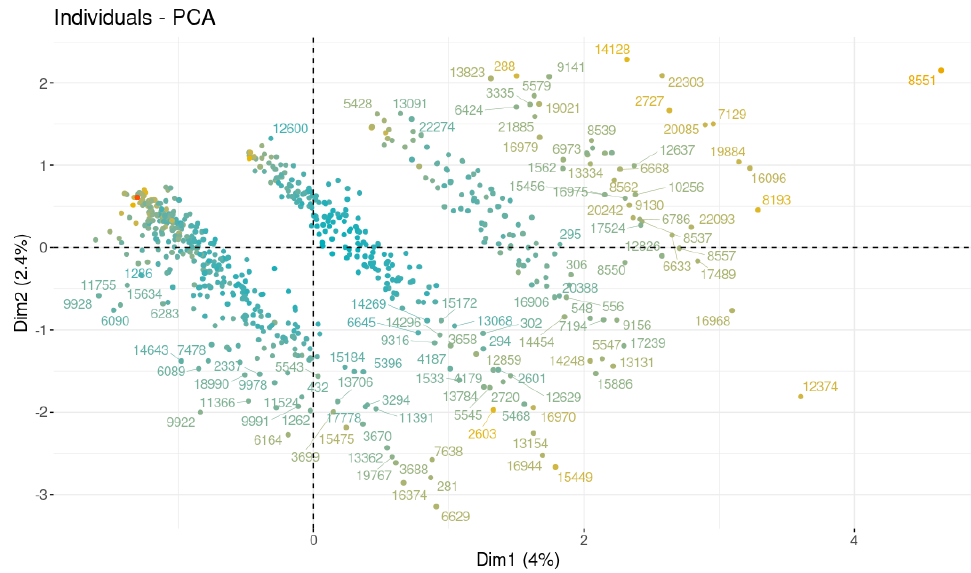
Figure 7. PCA of the reviews related to Jacket item. Numbers around points represent review IDs. The individual’s color (point) was randomly allocated according to their qualities of representation. Source: elaborated by the